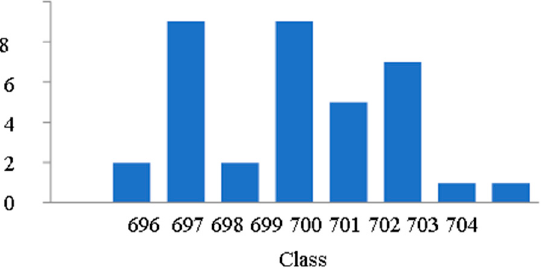
Figure 4. Histogram for a sample with 36